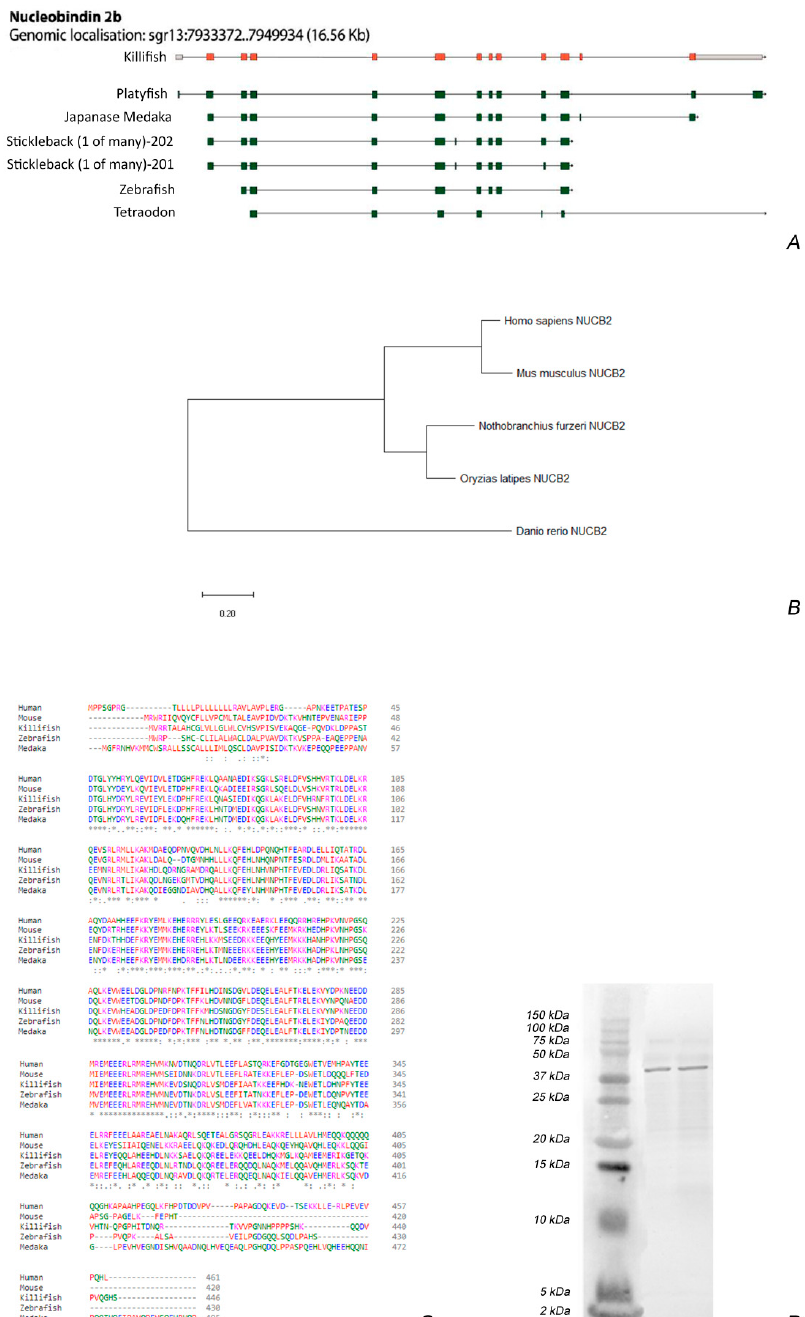
Figure 1. NUCB2B gene structure and Nesfatin–1 peptide analysis: ( A ) NUCB2B intron/exon gene structure of N. furzeri and alignment of transcripts from other fish species (downloaded and modified from http://nfingb.leibniz-fli.de/, transcript information for the other fish species can be found at http://www.ensembl.org/). The structure of the two paralogues NUCB2A and NUCB2B were highly similar. In the image, NUCB2B is shown as a template. ( B ) The evolutionary history of NUCB2B peptide sequences was inferred by using the Minimum Evolution method. The phylogenetic tree of amino acid sequences was reconstructed by MEGA X. ( C ) NUCB2B peptide sequence alignments in different species: Nothobranchus furzeri (killifish), Oryzias latipes (medaka), Carassius auratus (goldfish), Homo sapiens (human), and Mus musculus (mouse). Asterisks mark conserved amino acids (alignment was done with Clustal Omega http://www.ebi.ac.uk/Tools/msa/clustalo/). ( D ) Western blot in the brain of young and old killifish showing an immunoreactive band of about 40 kDa.